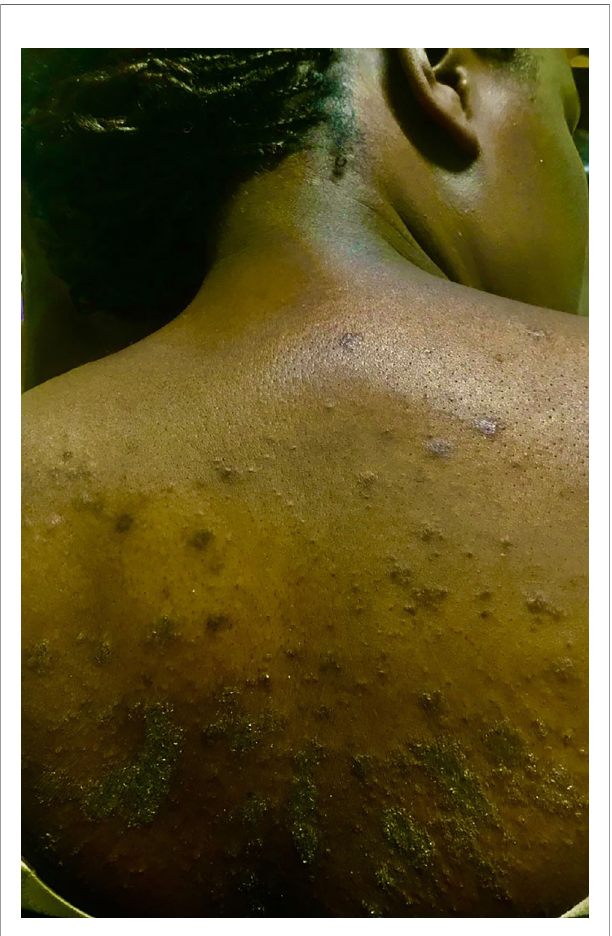
FIGURE 3 | Psoriasiform dermatosis in a patients with SSc speci fi c autoantibodies.